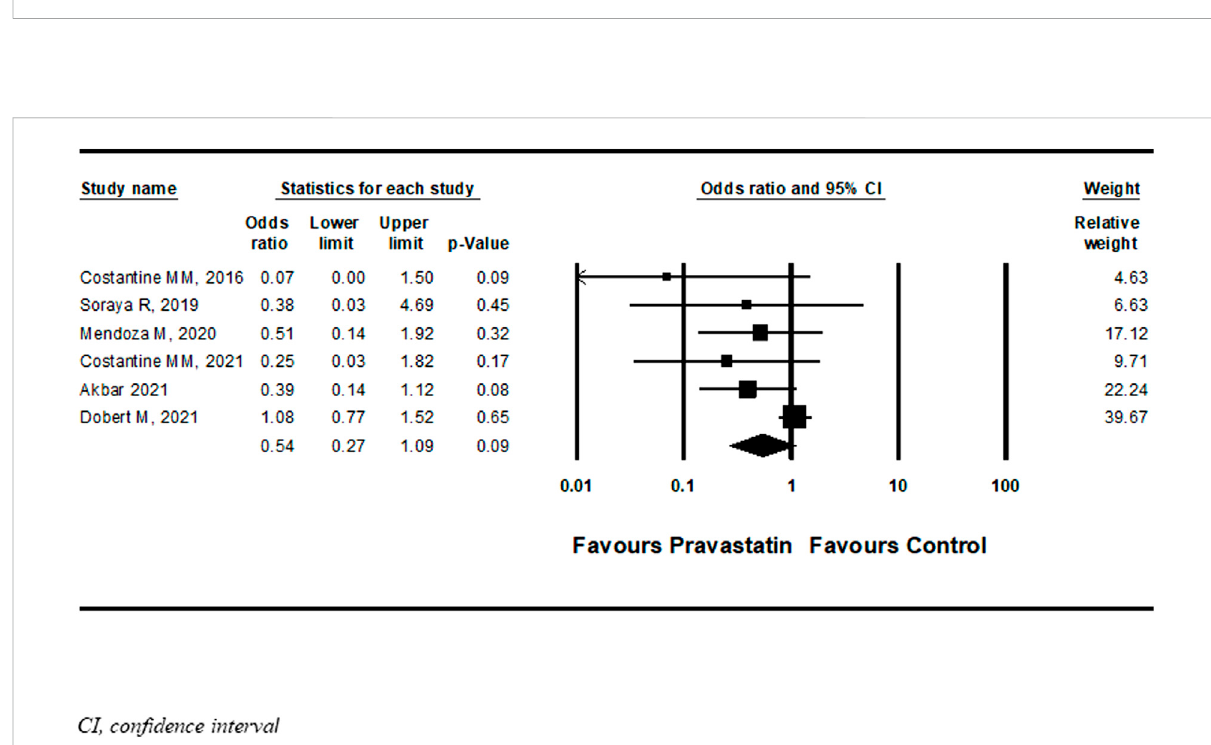
FIGURE 6 Meta-analysis results of the association of pravastatin treatment with new diagnoses of preeclampsia.